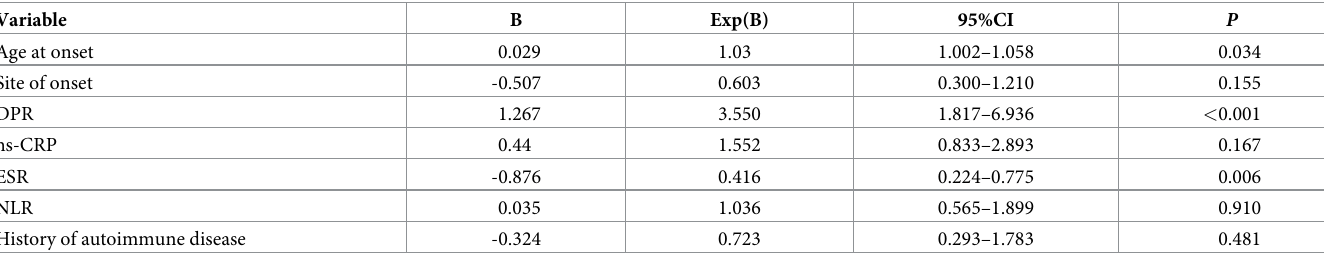
Table 3. Multiple regression analysis of prognostic factors for overall survival in the whole ALS patients.